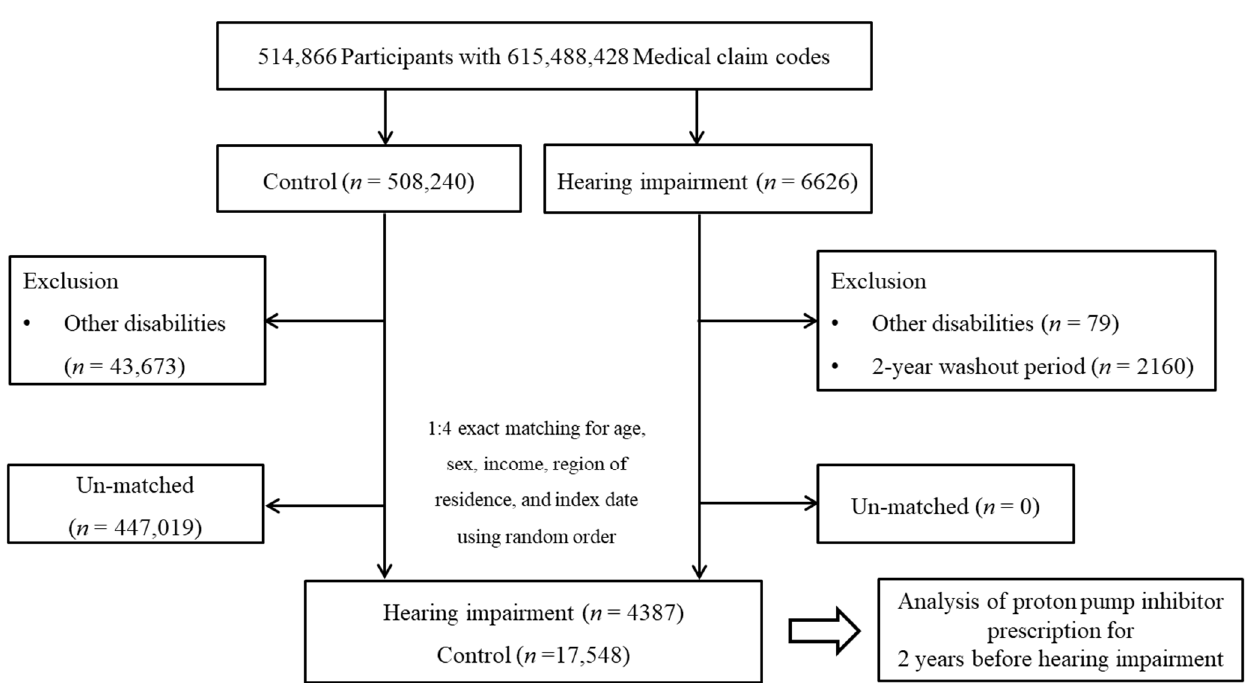
Figure 1. A schematic illustration of the participant selection process that was used in the present study.